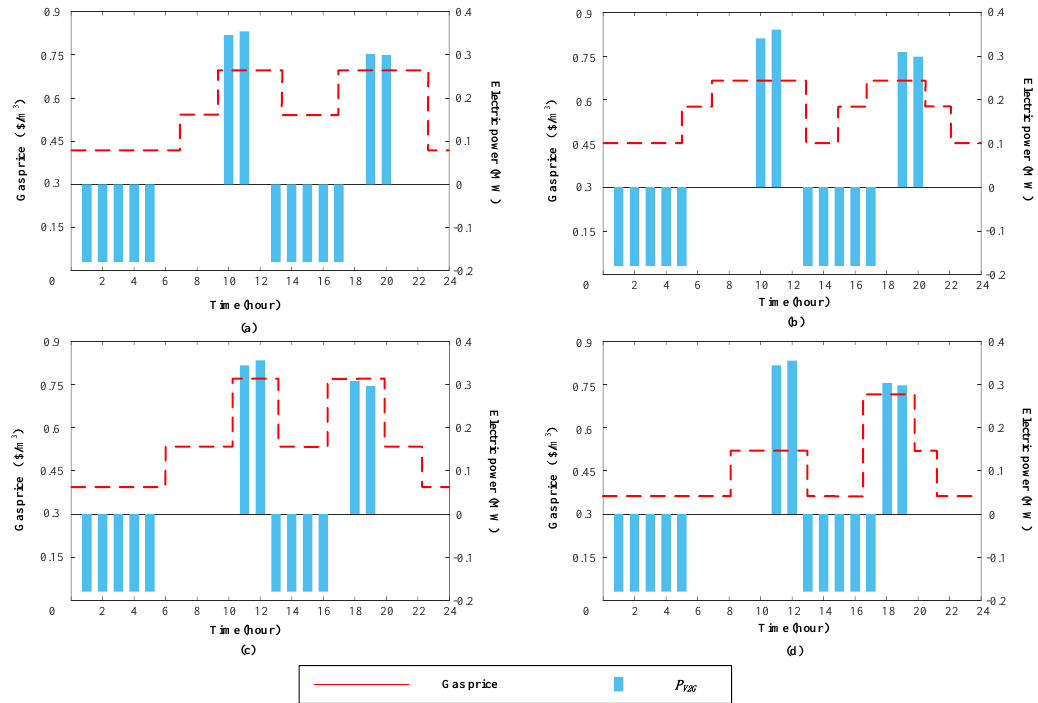
Figure 10. Optimal output power of the electric vehicle power station and time-of-use gas price in ( a ) spring; ( b ) summer; ( c ) autumn; ( d ) winter.